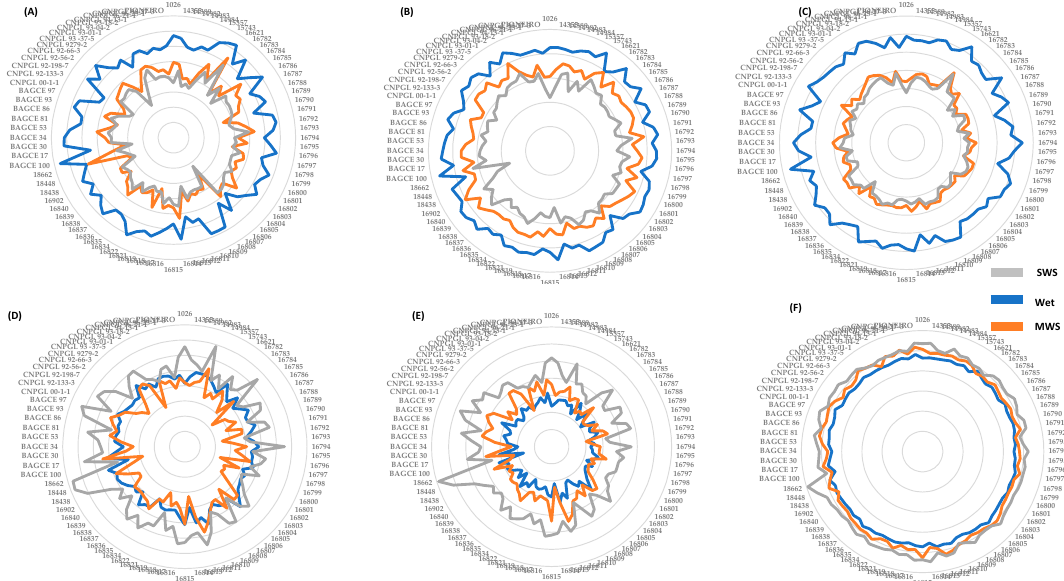
Figure A3. Radar plot showing changes in: ( A ) neutral detergent fiber, ( B ) acid detergent fiber, ( C ) acid detergent lignin, ( D ) crude protein, ( E ) in vitro organic matter digestibility and ( F ) metabolizable energy of Napier grass genotypes grown under rainy (wet), dry, moderate water stress (MWS) and severe water stress (SWS) conditions. The values of traits are expressed as % of dry matter. Table A7. ANOVA summary for seven feed quality traits of Napier grass genotypes for leaf and stem tissue in the wet season.